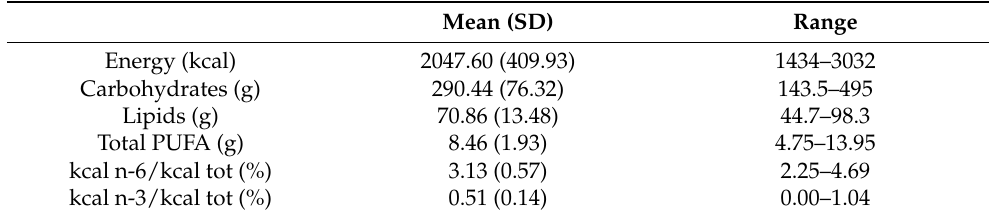
Table 2. Children’s nutritional status: average intake for energy and macronutrients and for SFA, PUFA, MFA, and ratios.